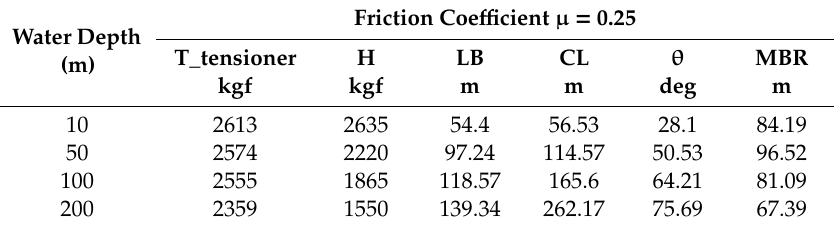
Table 7. Cable critical responses assuming friction coe ffi cient µ = 0.25.